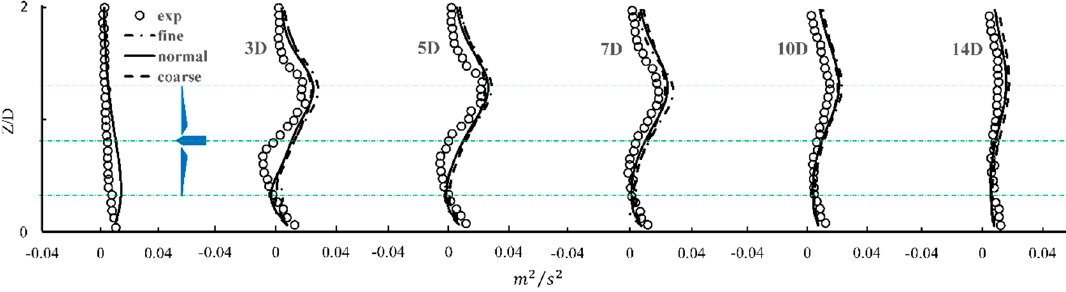
Figure 21. Vertical distribution of (cid:3398)(cid:1873) (cid:4593) (cid:1875) (cid:4593) (cid:3364)(cid:3364)(cid:3364)(cid:3364)(cid:3364)(cid:3364) simulated by different mesh schemes.